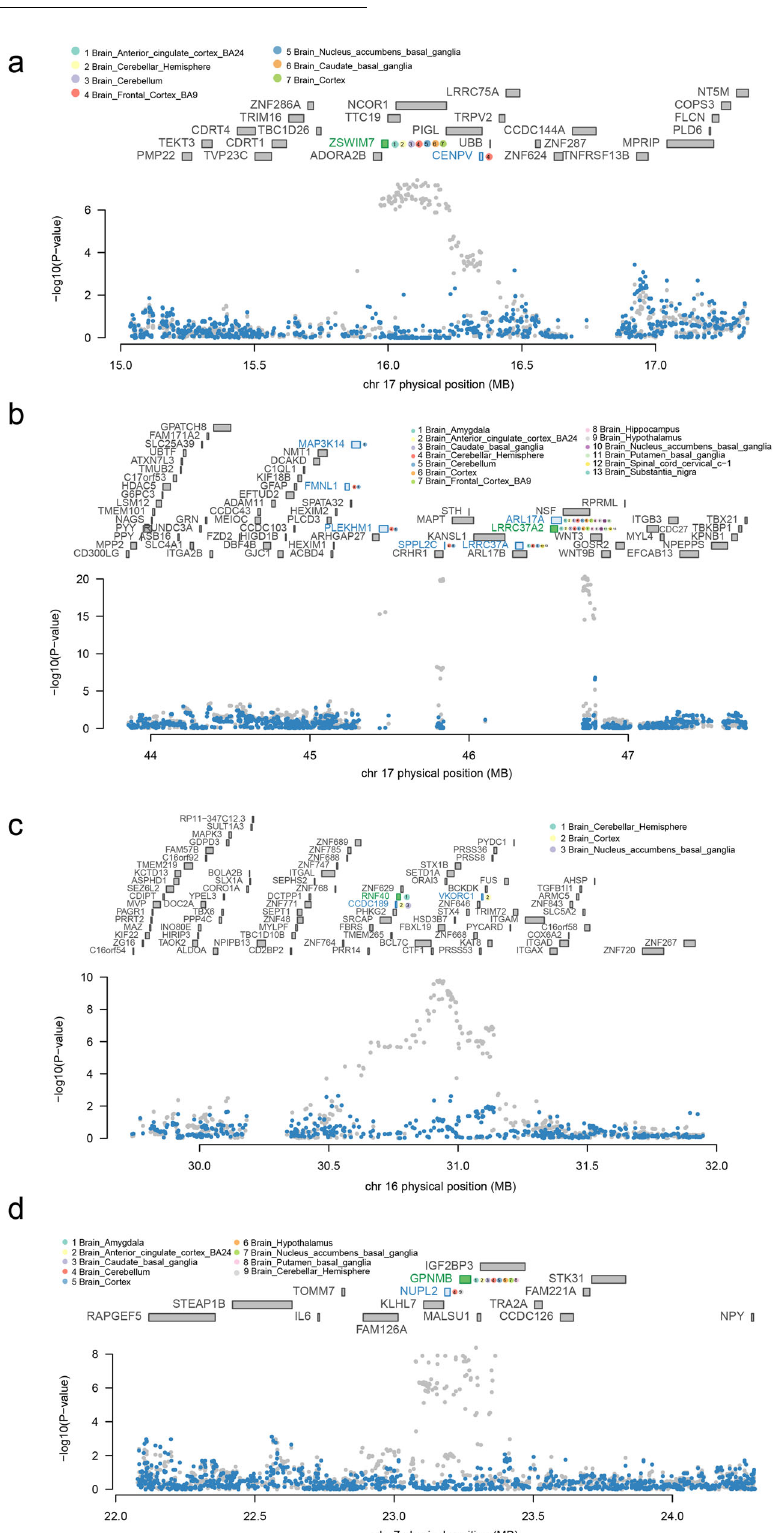
Fig. 3 Regional association of TWAS hits. a Chromosome 17 regional association plot (part 1). b Chromosome 17 regional association plot (part 2). c Chromosome 16 regional association plot. d Chromosome 7 regional association plot. The marginally associated TWAS genes are shown in blue, and the conditionally signi fi cant genes are shown in green. The bottom panel shows a regional Manhattan plot of the GWAS data before (gray) and after (blue) conditioning on the green genes ’ predicted